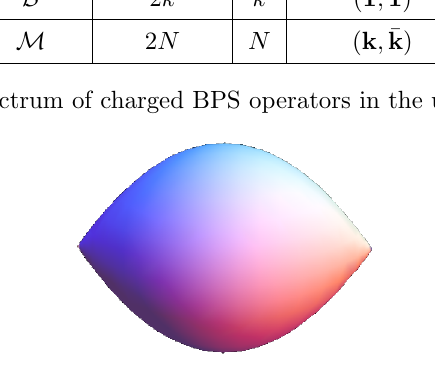
Figure 8 . A two-dimensional projection of the internal space M